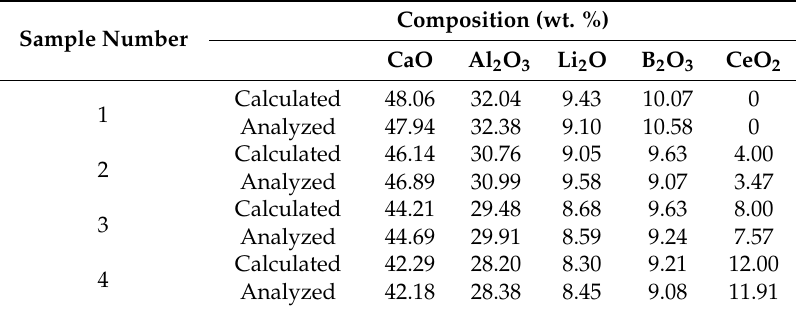
Table 1. The chemical composition of the experimental mold